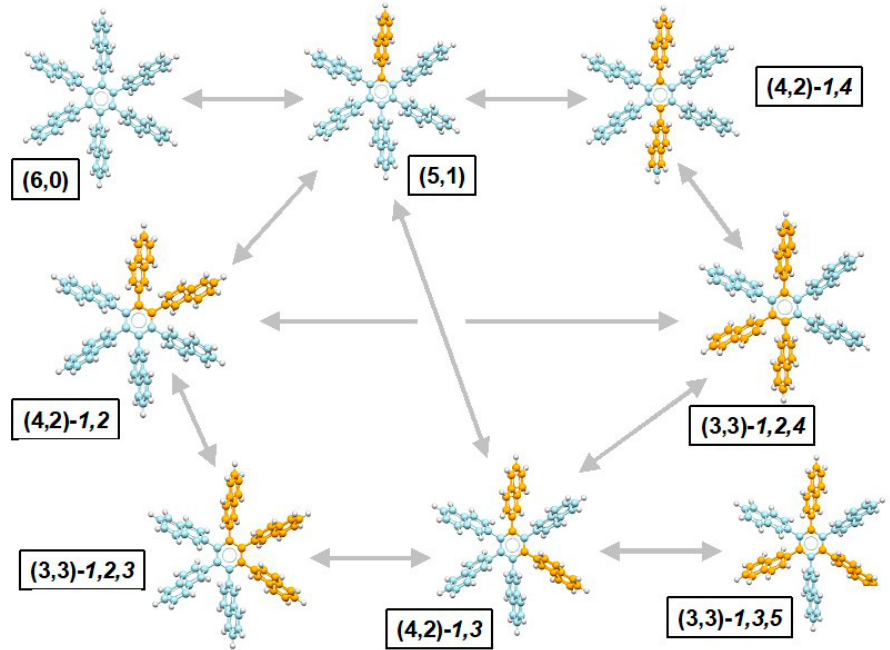
Figure 14. Synthesis and molecular structure of ferrocenyl-penta( β -naphthyl)benzene, 30 . Figure 14 is reprinted from the Canadian Journal of Chemistry; © Canadian Science Publishing or its